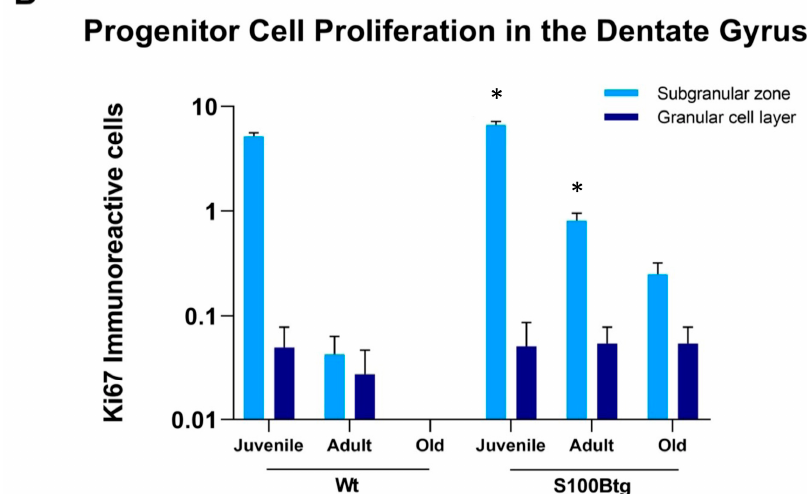
Figure 1. Progenitor cell proliferation in the dentate gyrus in S100Btg and wt mice. ( A ) Comparison of BrdU and Ki67 immunoreactive cells in the dentate gyrus; ( B ) Quantification of progenitor cell proliferation in the dentate gyrus following Ki67 immunostaining. Consider the logarithmic scale. Data are expressed as means ± SE (8 mice/group). * Indicates a statistically significant difference in comparison to wt controls (Student’s t -test, assuming p < 0.05).